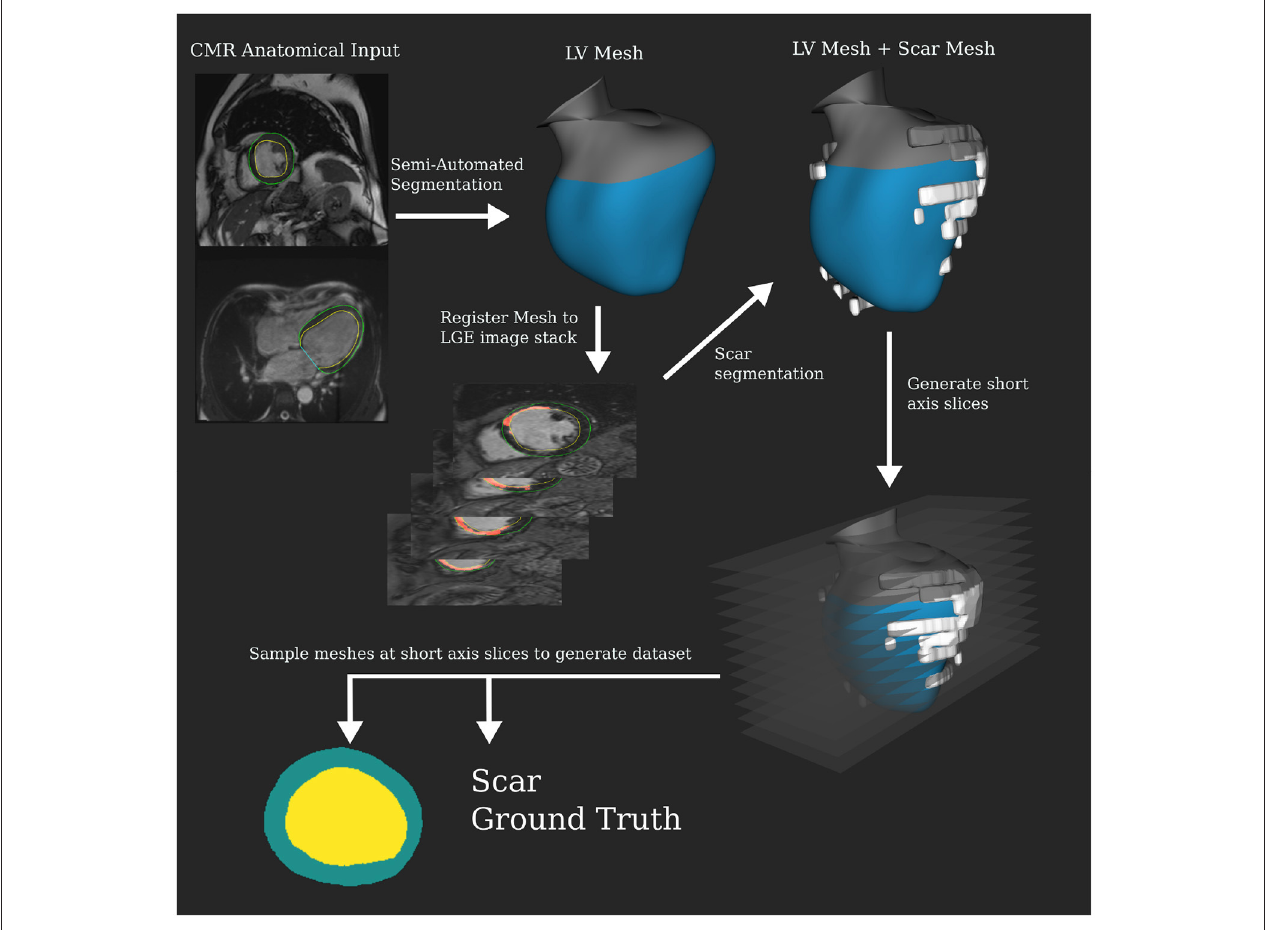
FIGURE 2 | Magnetic resonance imaging (MRI) dataset processing pipeline for training and